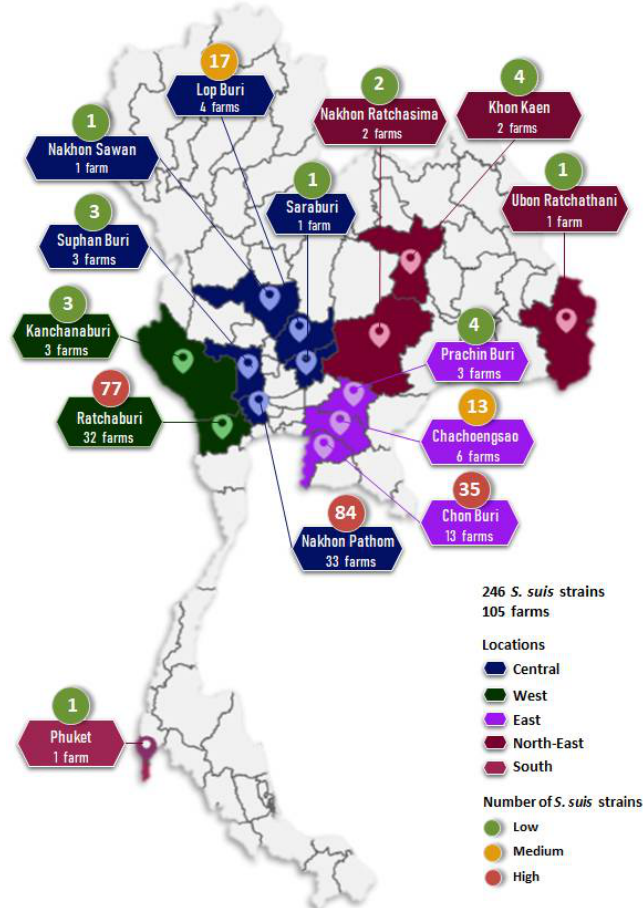
Figure 1. Geographic distribution of S. suis strains isolated from diseased pigs from 2018–2020.